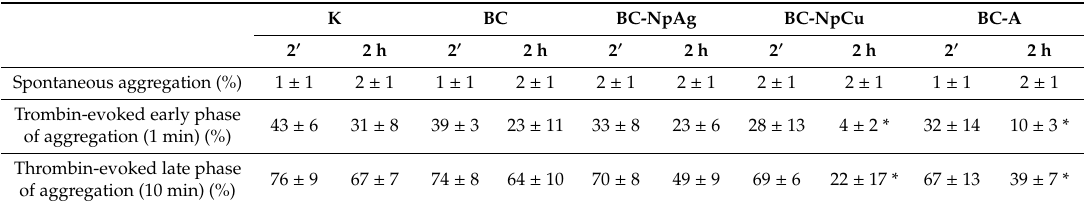
Table 3. E ff ect of cement specimens on platelet aggregation: Modified bone cements with 1.5% w / w of